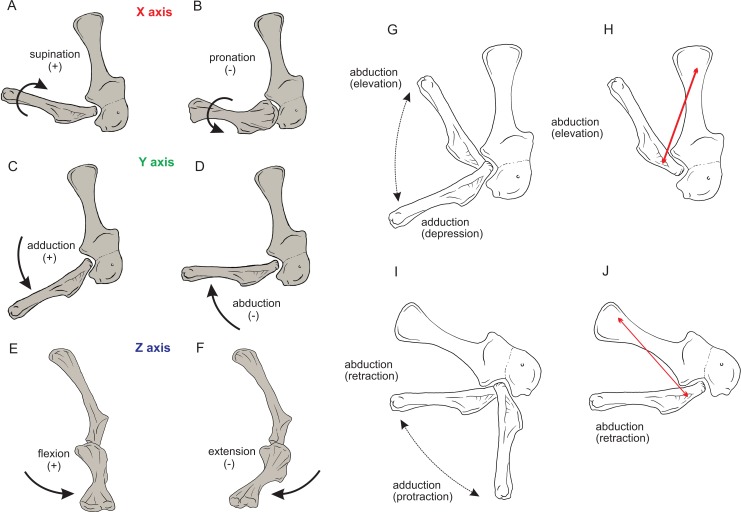
Joint axis nomenclature for the glenohumeral joint used in this study.Reference pose in Mussaurus patagonicus showing ‘X’ (A, B), ‘Y’ (C, D) and ‘Z’ (E, F) axes. Reference pose in Mussaurus showing the vertical scapular blade, with a caudal orientation of the glenohumeral joint, depicting abduction/adduction joint motion (G), and the elevation action of the M. deltoideus scapularis (red line) (H). Resting pose of Mussaurus showing the caudoventrally inclined scapular blade, with a caudoventral orientation of the glenohumeral joint, depicting abduction/adduction joint motion (I), and the retraction action of the M. deltoideus scapularis (red line) (J). Note that the movements/actions depicted in both the reference and resting poses are the same (i.e. they are homologous), but differ in the resulting functions performed, because of the reorientation of the glenohumeral joint via scapular reorientation.